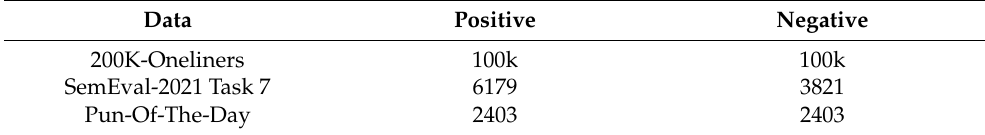
Table 1. Sample distribution of each